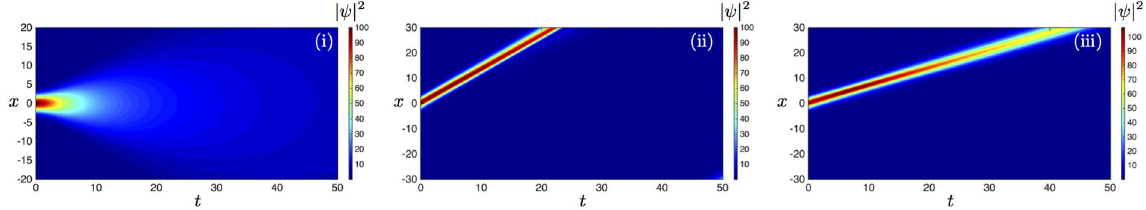
Figure 4. Density plots | ψ ( x , t )| 2 of the equilibrium condensate wave function predictions for the full polariton dispersion at different k . ( i ) Corresponds to k = 0, ( ii ) to k = 2.2 and ( iii ) to k = 4. In the simulations a 4 th order time splitting in time with Δ h = 0.005, Δ t = 0.005 was used. A very large domain [ − 50, 50] was employed to make sure the value of the solution on the boundary is negligible. Numerical parameters were α = 0.001, V 0 = 0 and δ = 0.004.